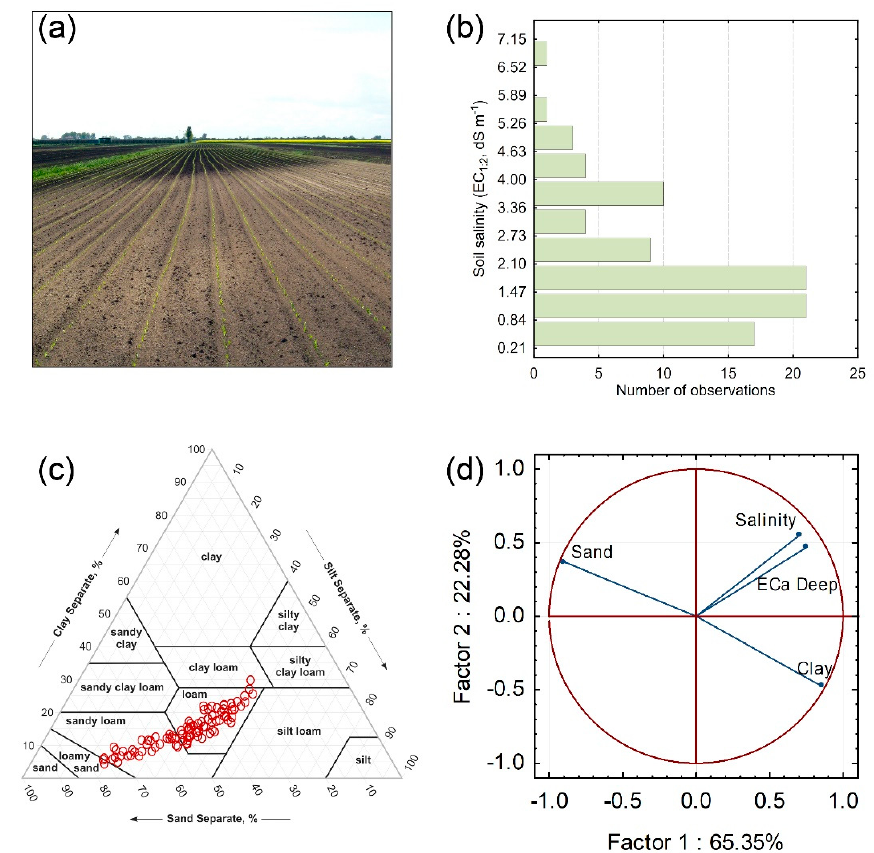
Figure 3. ( a ) Photograph showing the sharp textural change at the site (light vs. dark colors); ( b ) histogram for measured soil salinity (EC 1:2 ); ( c ) soil textural triangle; and ( d ) bi-plot of selected variables (soil apparent electrical conductivity [EC a Deep], salinity, clay, and sand) on the two larger factors in the principal components analysis.